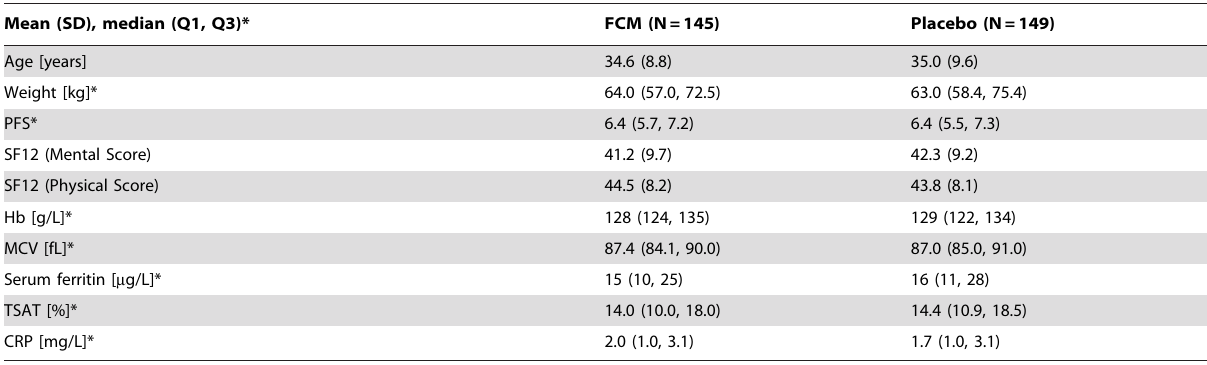
Table 1. Patient baseline characteristics,